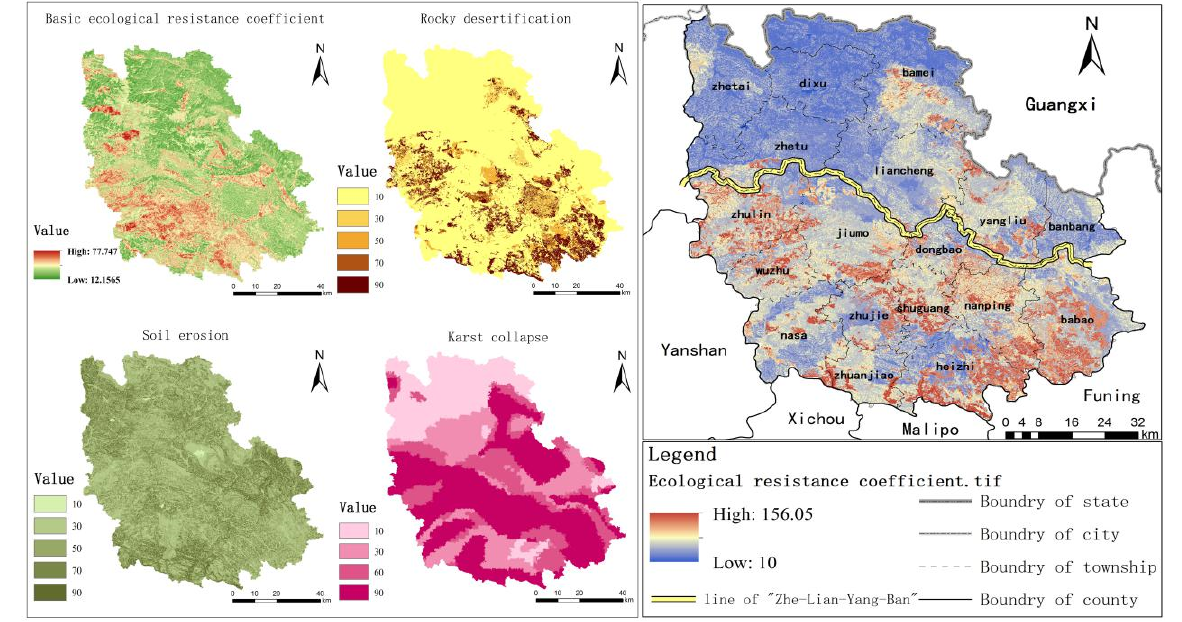
Figure 6. Construction of comprehensive resistance surface in Guangnan